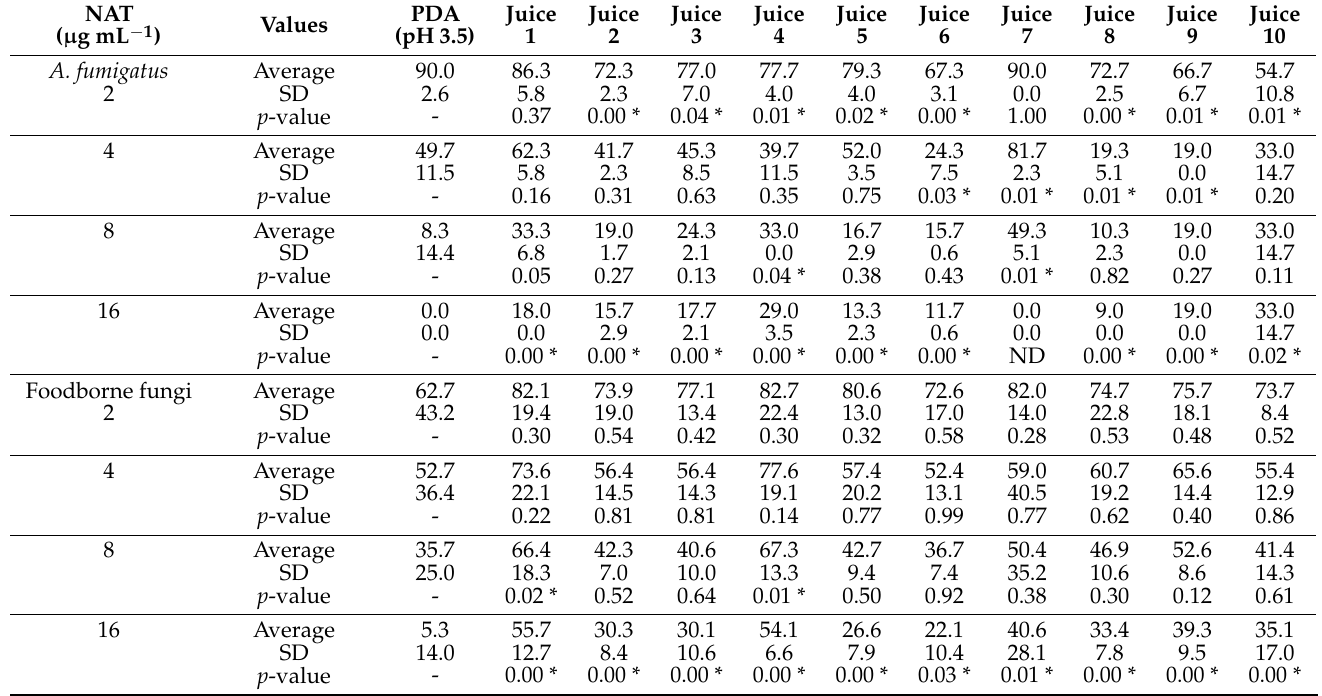
Table 2. Levels of fungal susceptibility to NAT in different fruit juices.